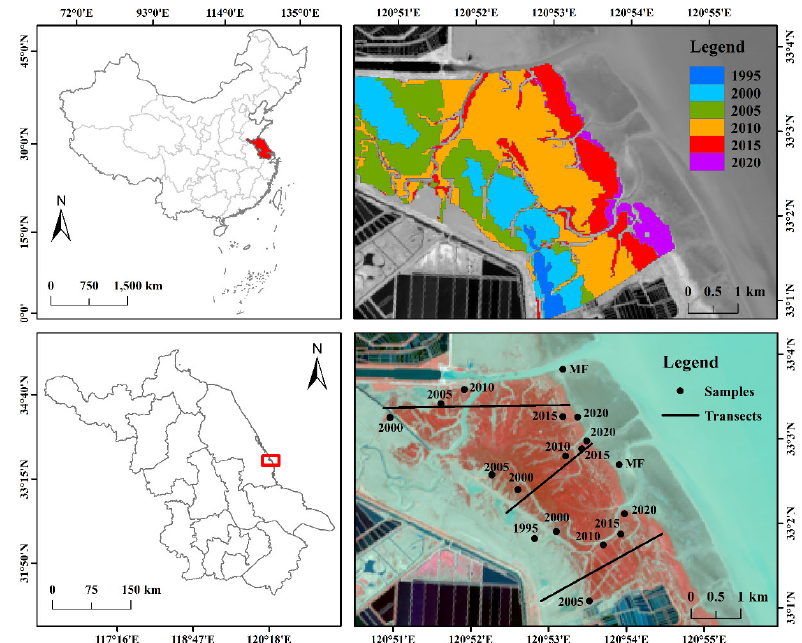
Figure 1. Location and sampling site